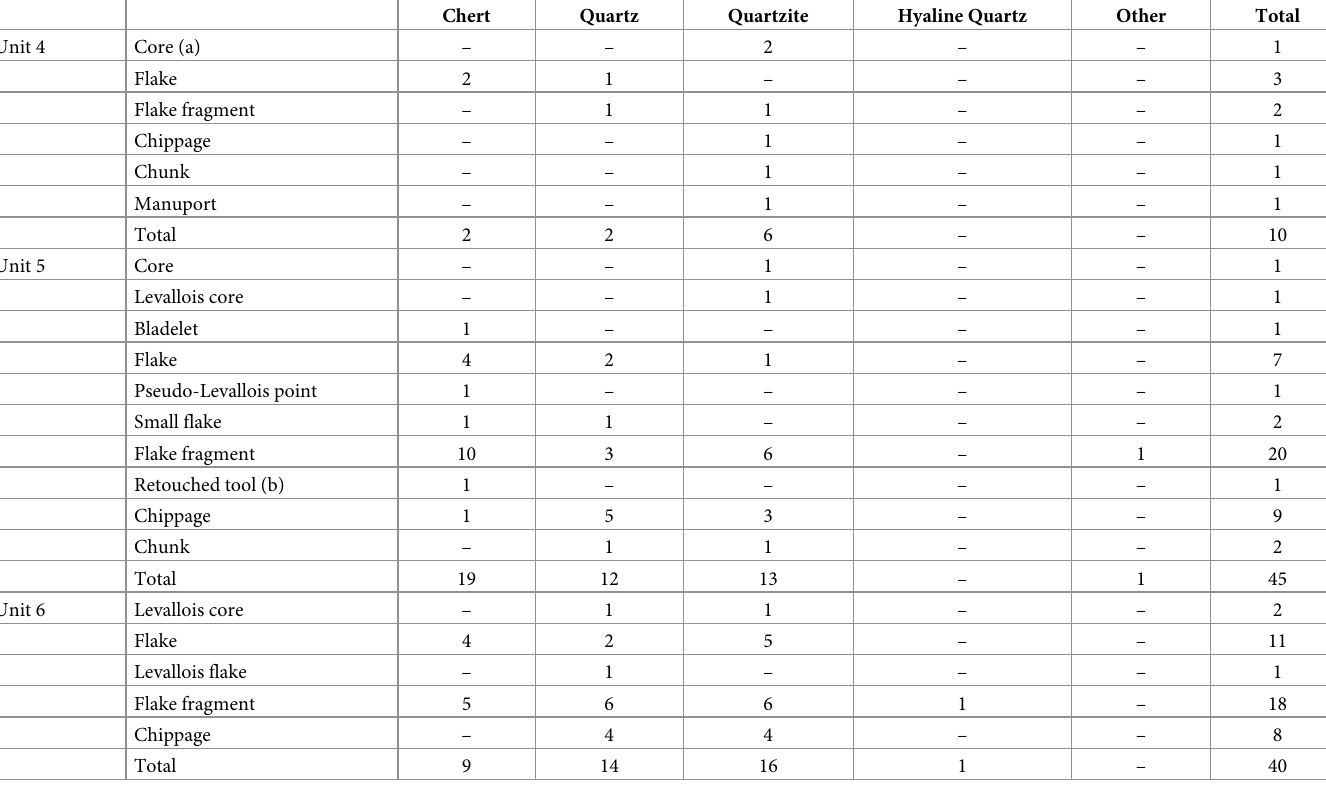
Table 9. Entrance